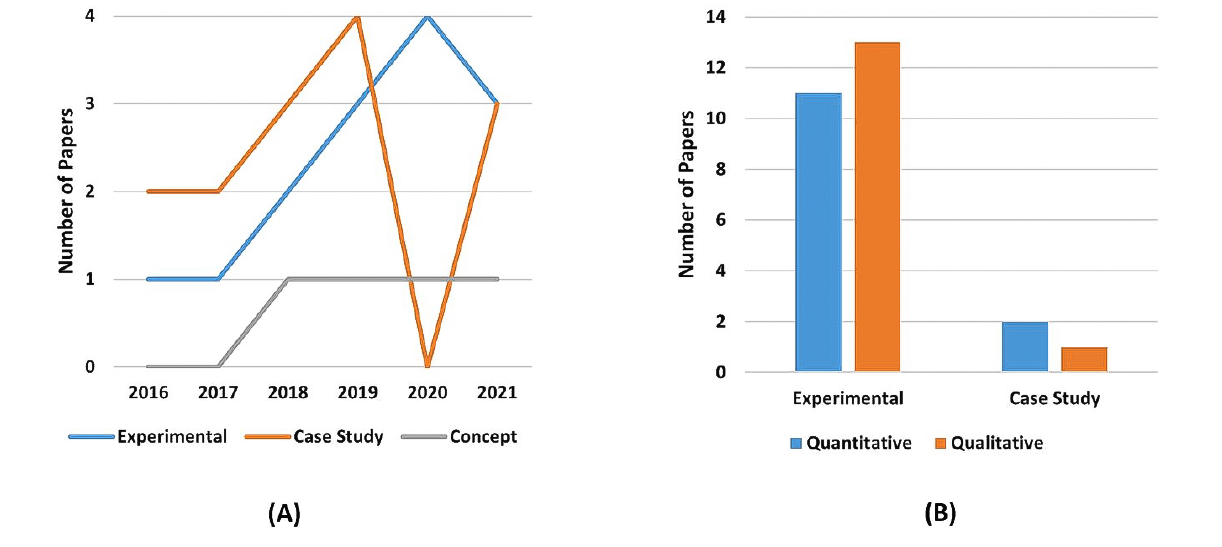
Figure 23. ( A ) Evaluation methodology by research type; ( B ) type of study over